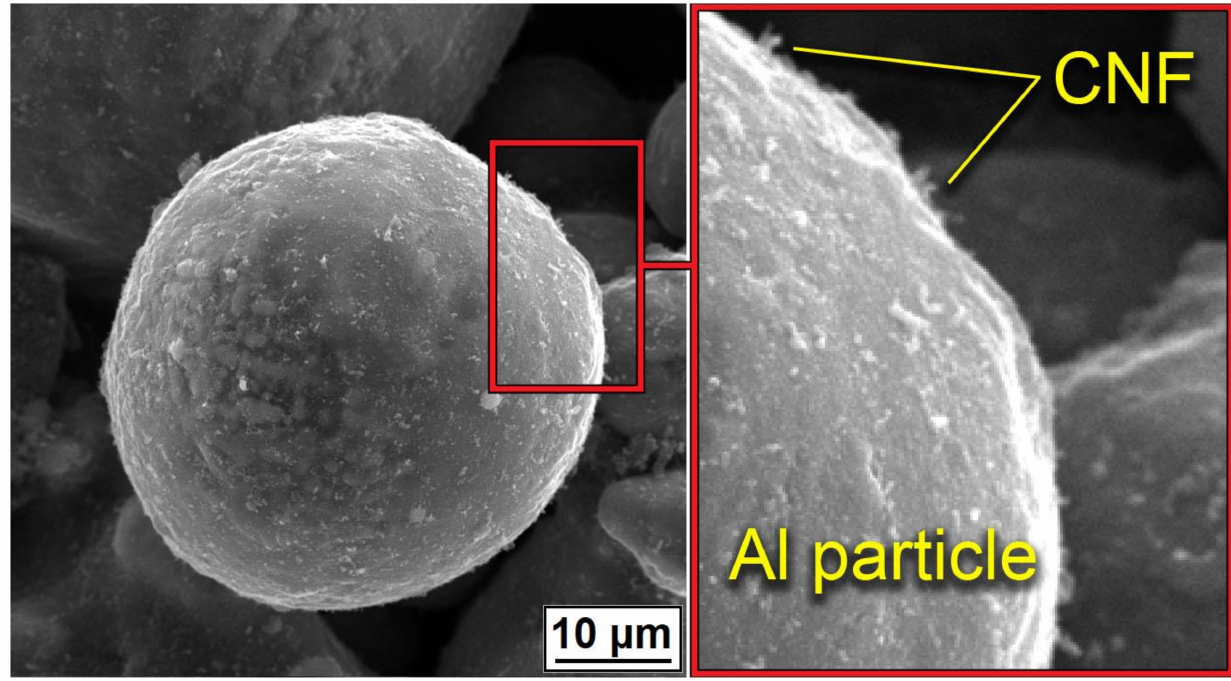
Figure 3. Distribution of CNF on the surface of Al powder after